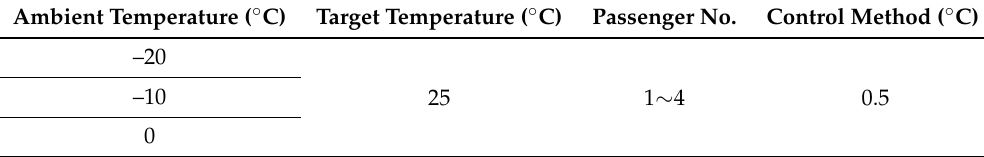
Table 4. The cabin experimental conditions.